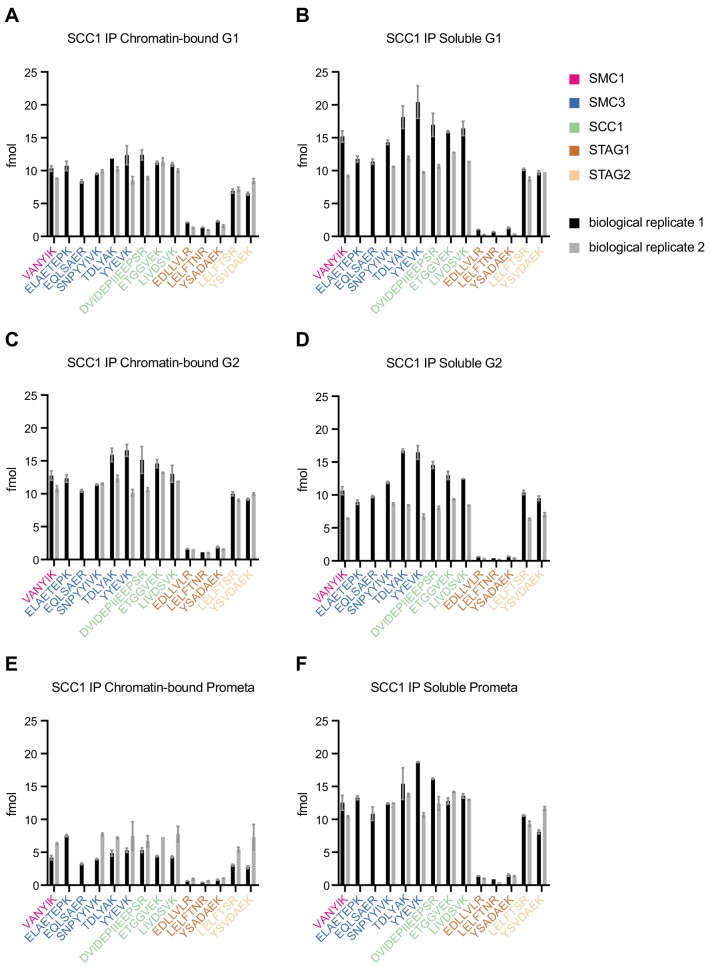
LC-MS quantification of cohesin subunit stoichiometry.Absolute quantification of individual SMC1, SMC3, SCC1, STAG1 and STAG2 peptides used to generate the mean cohesin subunit ratios shown in Figure 1—figure supplement 3. Data are mean ± standard deviation of two technical replicates. A single technical replicate was quantified in one of the two biological replicates for peptides TDLYAK (G1 chromatin), YSVDAEK (G1 soluble), LELFTNR (G2 chromatin and soluble) and ETGGVEK (prometaphase chromatin). A single technical replicate was quantified in both of the biological replicates for peptide LELFTNR (prometaphase soluble).